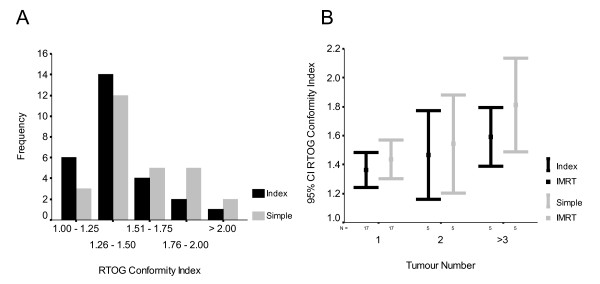
Distribution of RTOG Conformity Index depending on IMRT plan (A) and the 95% confidence interval and mean values shown for different number of tumours and IMRT plan (B).